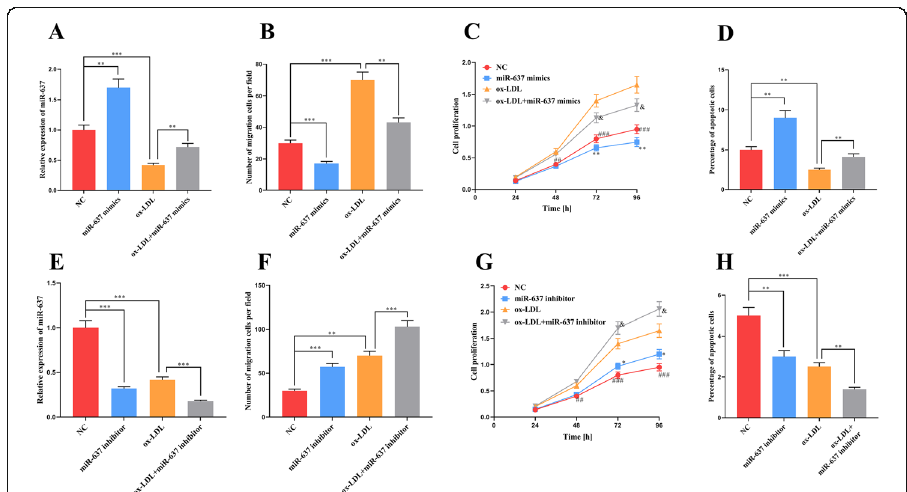
Fig. 2 The effects of miR-637 on proliferation, migration and apoptosis of VSMCs. a – MiR-637 mimics were successfully transfected into VSMCs and VSMCs treated with 100 mg/l ox-LDL for 24 h. b – The migration of VSMCs was tested using a Transwell assay after transfection with miR-637 mimics. c – A CCK-8 assay was used to determine the effect of transfection with miR-637 mimics on the proliferation of VSMCs. d – The apoptosis rate of VSMCs was determined after transfection with miR-637 mimics. e – MiR-637 inhibitors were successfully transfected into VSMCs and VSMCs treated with 100 mg/l ox-LDL for 24 h. f – The migration of VSMCs was tested using a Transwell assay after transfection with miR-637 inhibitors. g – A CCK8 assay was used to determine the effect of transfection with miR-637 inhibitors on the proliferation of VSMCs. h – The apoptosis rate of VSMCs was determined after transfection with miR-637 inhibitors. *, ** and *** respectively indicate p < 0.05, p < 0.01 and p < 0.001. In Fig. C, * indicates p < 0.5, NC group VS miR- 637 mimics group; & indicates p < 0.5, ox-LDL group VS ox-LDL + miR-637 mimics group; ### indicates p < 0.001, NC group VS ox-LDL group. In Fig. G, * indicates p < 0.05, NC group VS miR-637 inhibitor group; & indicates p < 0.05, ox-LDL group VS ox-LDL + miR-637 inhibitor group; ### indicates p < 0.001, ox-LDL group VS NC